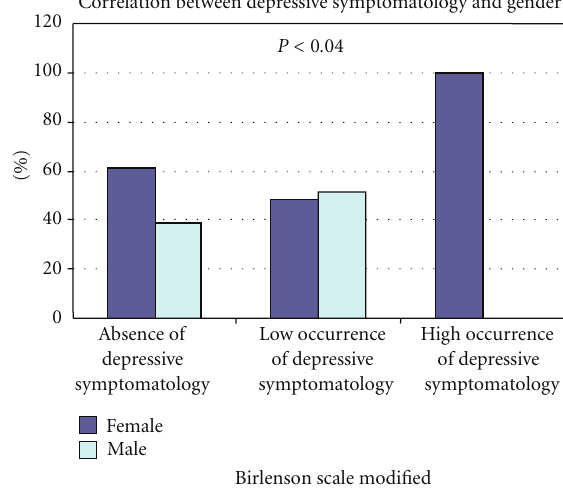
Figure 1: Correlation between depression symptomatology and